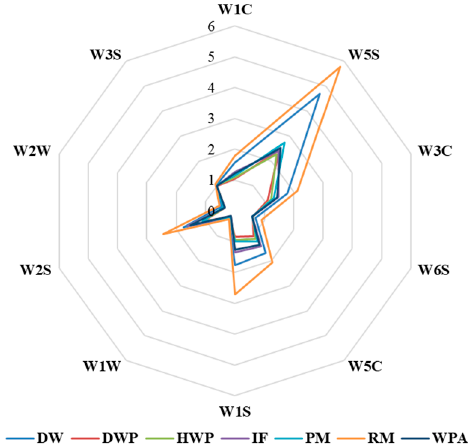
Figure 5. Distribution of the volatile compound species in the samples using E-nose sensors. RM, raw milk; PM, pasteurized milk; DW, demineralized whey; DWP, demineralized whey powder; HWP, hydrolyzed whey protein powder; WPA, whey protein powder with added alpha-lactalbumin; IF, infant formula.